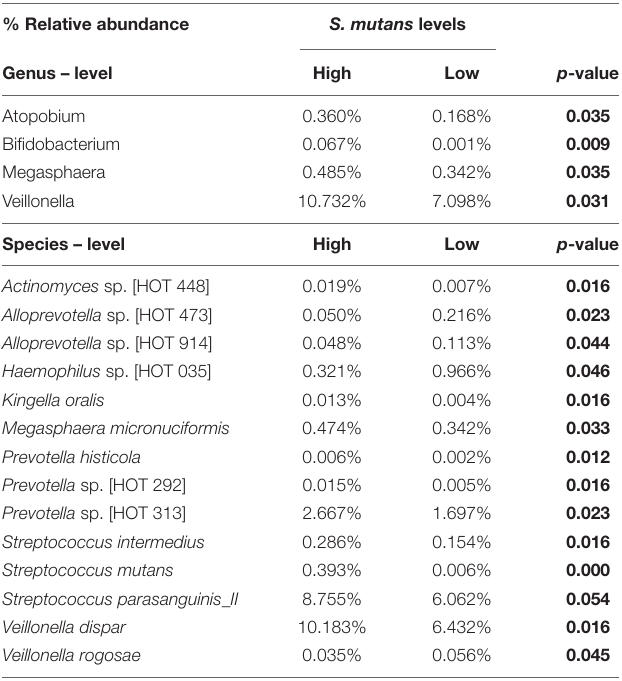
TABLE 2 | Relative abundance of the genus and species- level OTUs detected in the saliva, that were significantly different between high and low S. mutans samples.